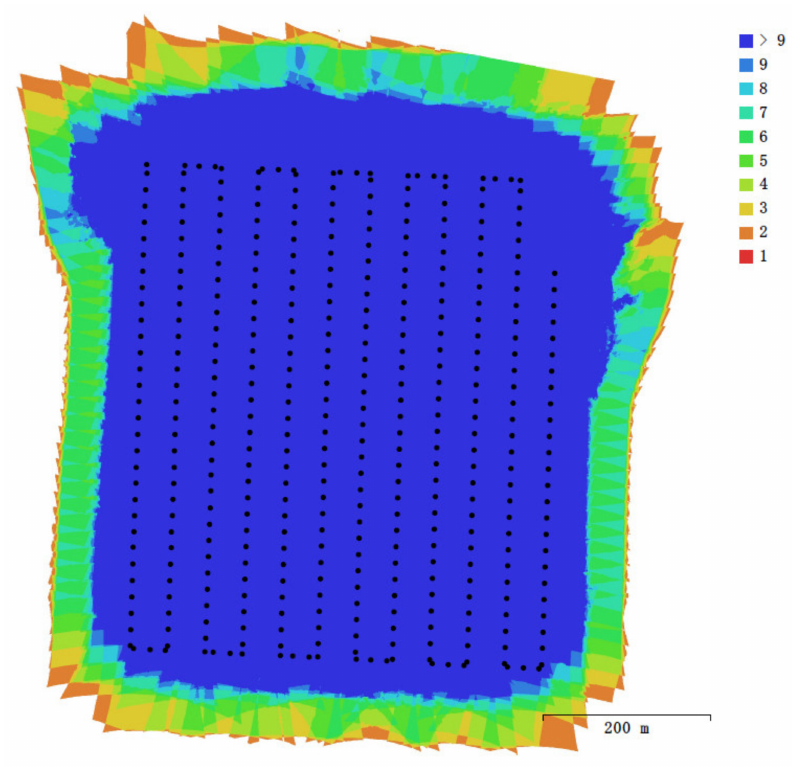
Figure 4. Camera location and image